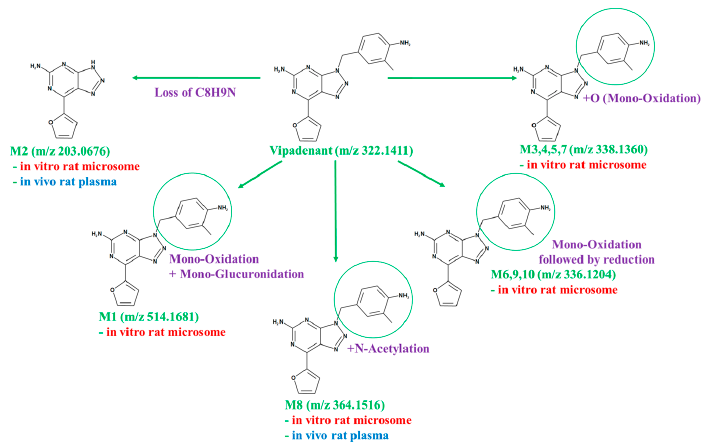
Figure 6. Metabolic pathways of vipadenant in vitro/vivo.